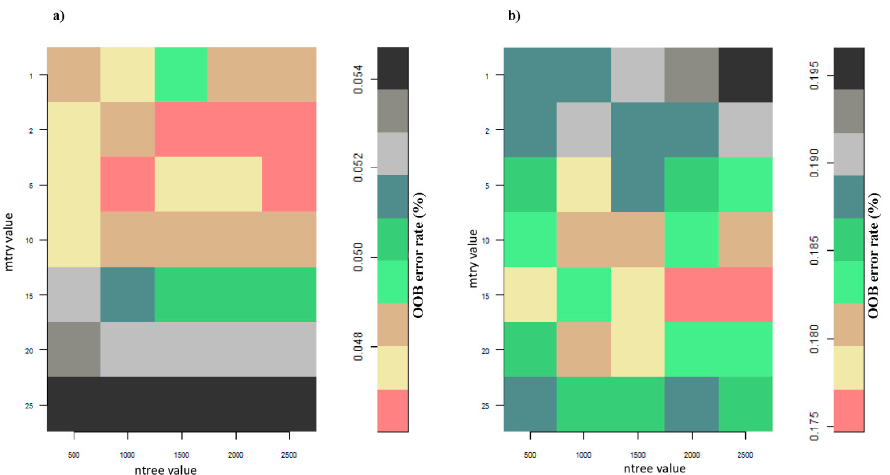
Figure 3. Random forest (RF) mtry and ntree optimization grid for the land use land cover (LULC) classification result ( a ) and for the mono- and mixed maize cropping systems mapping result ( b ) using the internal out-of-bag (OOB) error rate of RF resulting from a grid search with a tenfold cross validation setting.